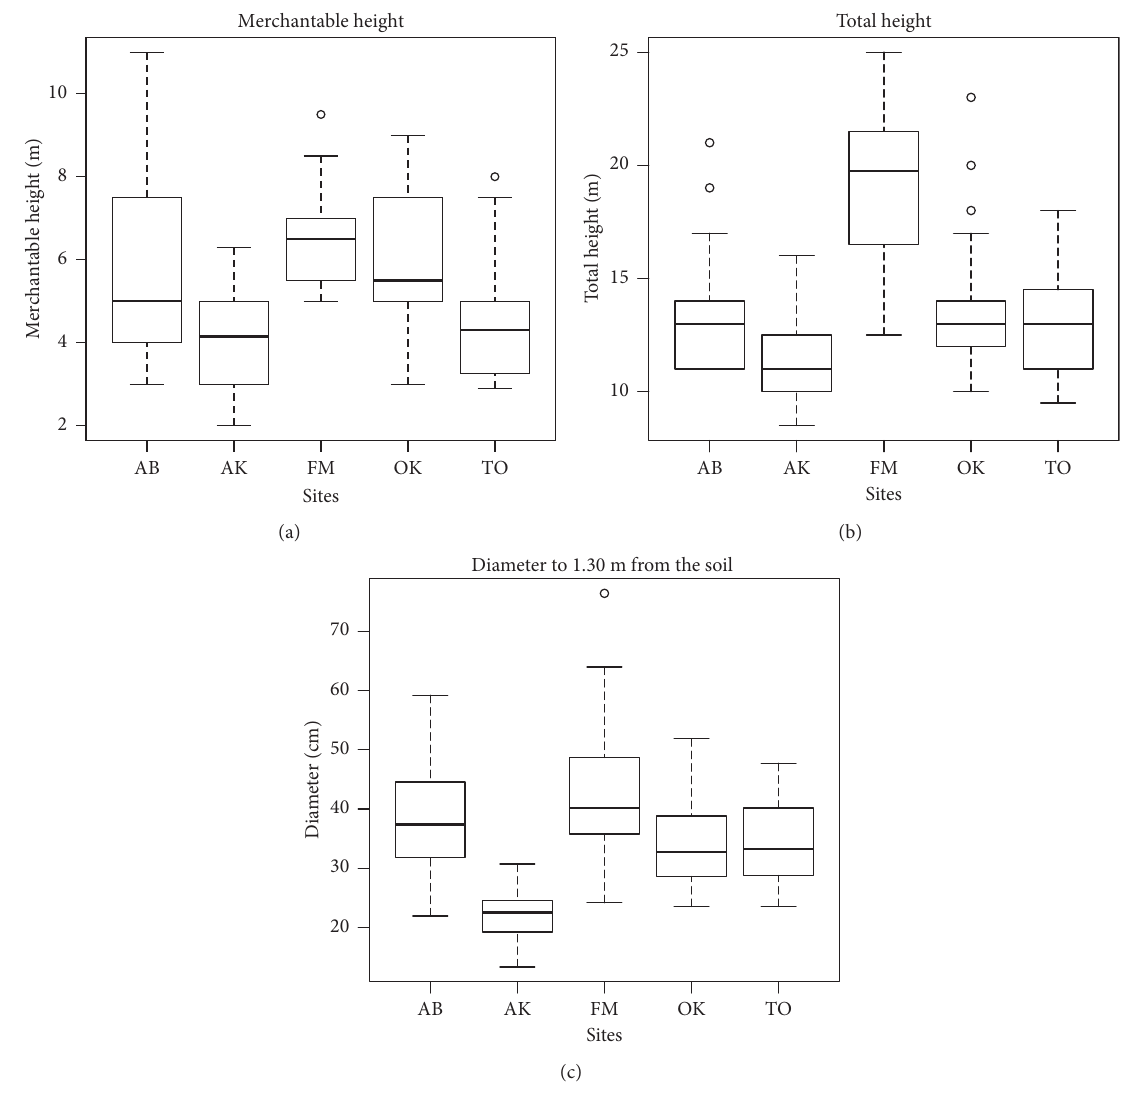
Figure 7: Distribution of tree dendrometric characteristics at the five sites. Table 6: Mean values of dendrometric parameters according to the climate